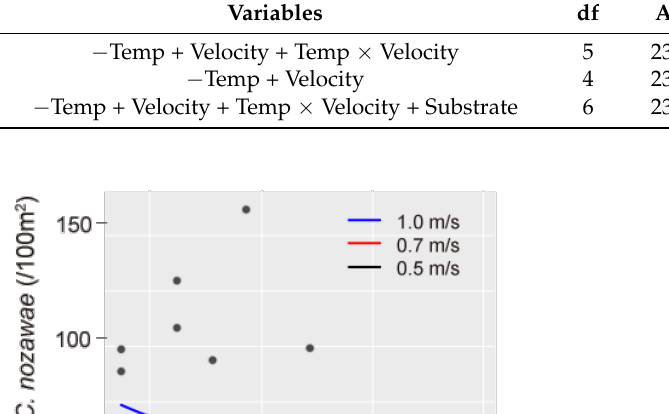
Table 2. Results of model selection for the abundance analysis. The top three models are shown. “Temp”, “Velocity”, and “Substrate” represent the mean summer water temperature, mean current velocity, and proportion of large substrates, respectively. “Temp * Velocity” indicates the interactive term between the mean summer water temperature and the mean current velocity. “df”, “ ∆ AIC” and “Weight” indicate the degrees of freedom, delta Akaike’s information criterion, and Akaike weight, respectively. Plus and minus symbols indicate positive and negative estimated coefficients, respectively.